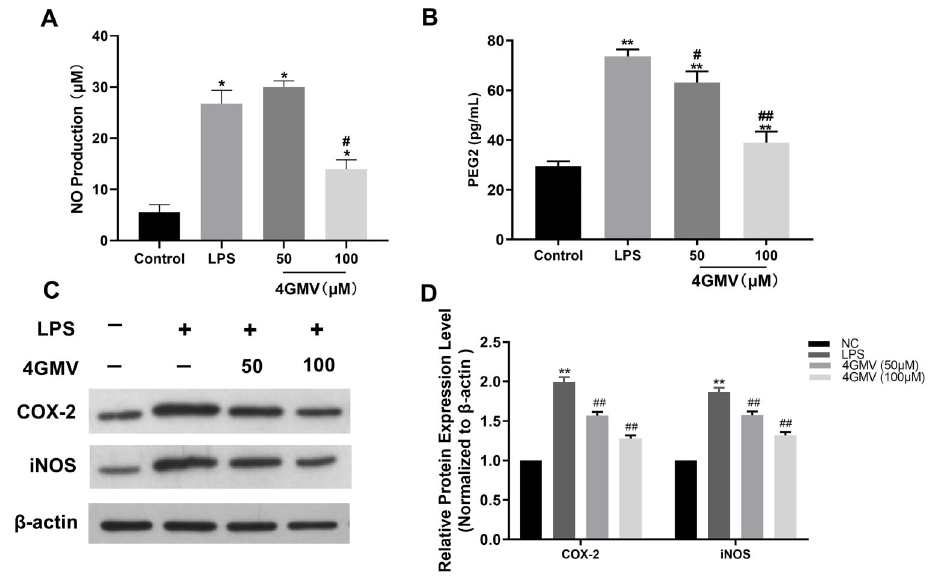
Figure 5. Effect of 4 ’ -O- b -D-glucosyl-5-O-methylvisamminol (4GMV) on the expression of nitric oxide (NO), prostaglandin E2 (PGE2), cyclo-oxigenase-2 (COX2), and inducible nitric oxide synthase (iNOS) in RAW 264.7 cells. RAW 264.7 cells were pretreated with different concentrations of 4GMV (50 and 100 m M) for 1 h prior to treatment with 1 m g/mL lipopolysaccharide (LPS). A , NO production was measured by the Griess test. B , The production of PGE2 was detected in the culture supernatants. C , Protein expression of COX-2 and iNOS was examined by western blotting. D , Quantitation of band density. Data are reported as means ± SD (n=3) from three independent experiments. *P o 0.05 and **P o 0.01 compared with the control group; # P o 0.05 and ## P o 0.01 compared with the LPS group (ANOVA followed by LSD). NC: negative control ( b